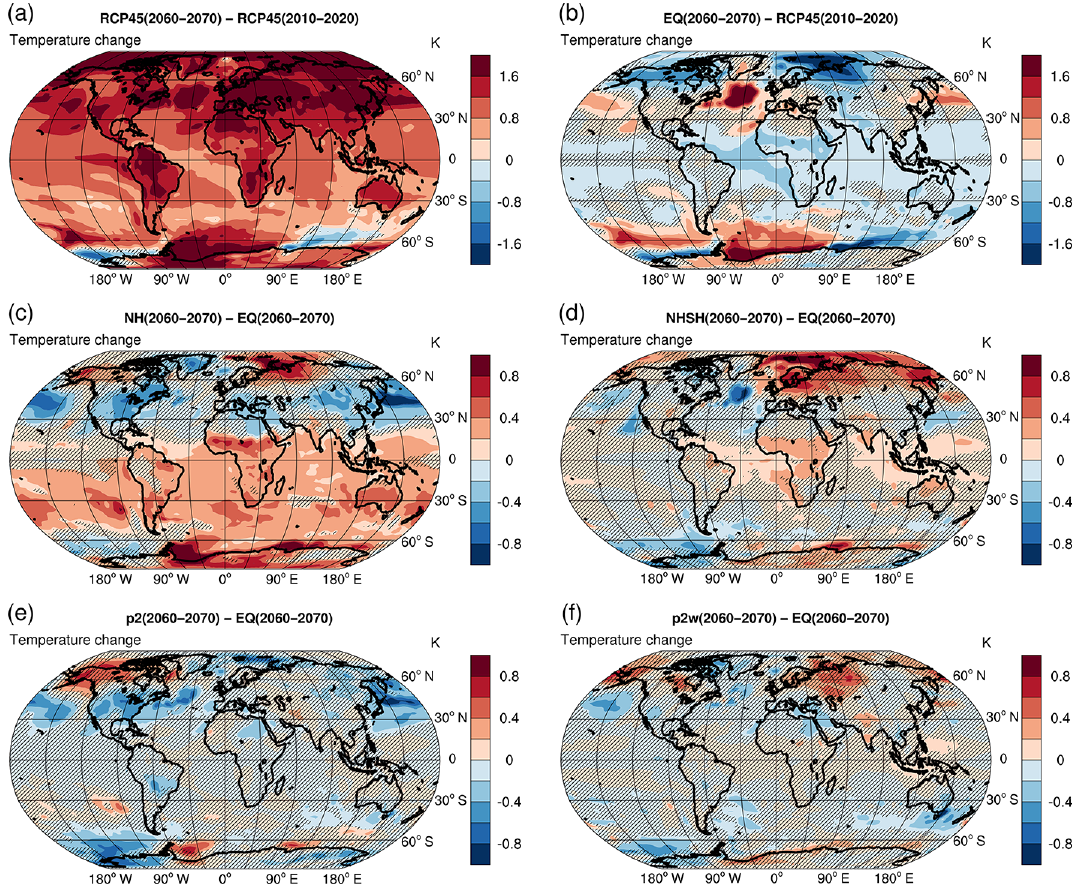
Figure 8. Temperature anomalies for (a) RCP45, (b) EQ, (c) NH, (d) NHSH, (e) p2 and (f) p2w. Anomalies in (a, b) are presented as differences between years 2060–2070 and 2010–2020. Anomalies in (c, d, e, f) are presented as a difference to EQ between years 2060– 2070. The hatching indicates regions where the change of the temperature is not statistically significant at 95%